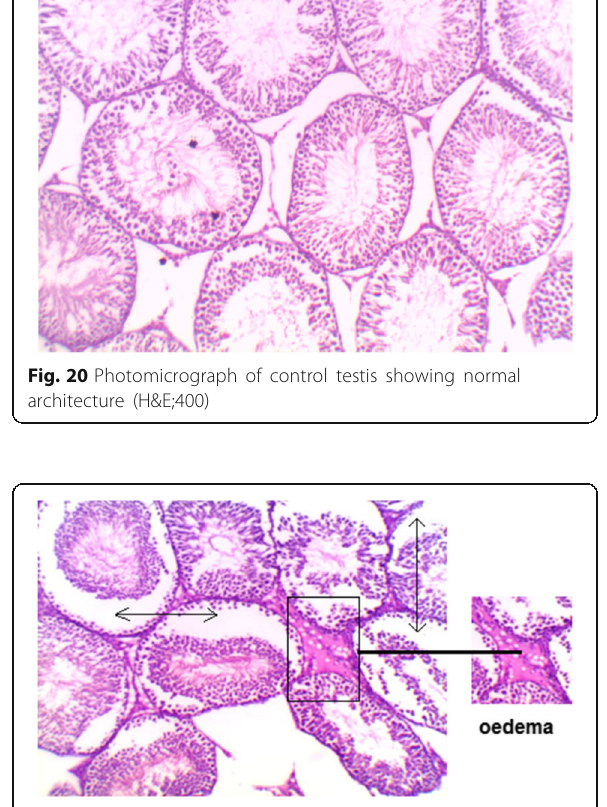
Fig. 21 Photomicrograph of CCl4-treated testis sections showing sloughing and destruction of walls of seminiferous tubules and oedema (H&E; ×400)